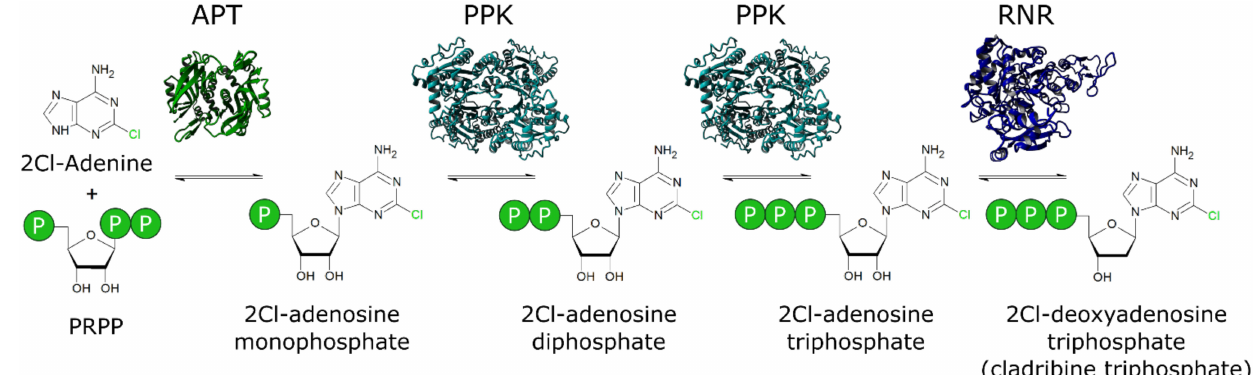
Figure 1. A novel cascade for the biosynthesis of non-natural deoxyribonucleotides: The adenine phosphoribosyltransferase (APT) catalyzes the loading of the nucleobase 2Cl-adenine on the ribose moiety in the form of phosphoribosyl pyrophosphate (PRPP). The polyphosphate kinase (PPK) performs two consecutive phosphorylation reactions to form 2Cl-adenosine triphos- phate. The ribonucleotide reductase (RNR) catalyze the reduction to the final product 2Cl-deoxyadenosine-triphosphate.